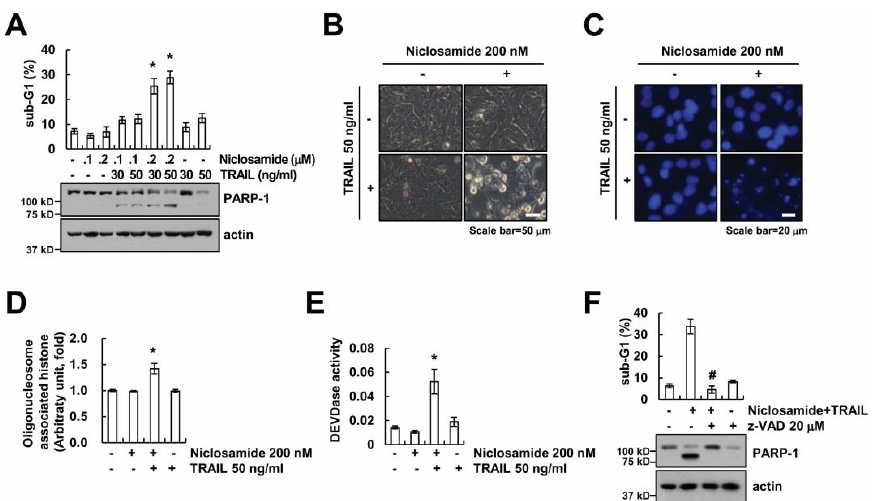
Figure 1. Niclosamide combined with TRAIL enhances apoptosis in Caki cells. ( A ) Apoptosis levels were detected by flow cytometry in Caki cells after treatment with niclosamide (100, 200 nM) and/or TRAIL (30, 50 ng/mL) for 24 h. ( B – E ) Representative image ( B ), 4′,6′-diamidino-2-phenylindole (DAPI) image ( C ), DNA fragmentation assay ( D ), and caspase activity assay ( E ) were determined by microscopy or assay kit in Caki cells after incubation with 200 nM niclosamide and/or 50 ng/mL TRAIL for 24 h. ( F ) Apoptosis levels were detected by flow cytometry in Caki cells after pretreatment with 20 µ M z-VAD-fmk (z-VAD) for 30 min, followed by treatment with 200 nM niclosamide and 50 ng/mL TRAIL for 24 h. Western blotting detects the protein expression ( A , F ). The values in graph ( A , D – F ) represent the mean ± SEM of three independent samples. * p < 0.01 compared to the control. # p < 0.01 compared to the niclosamide plus